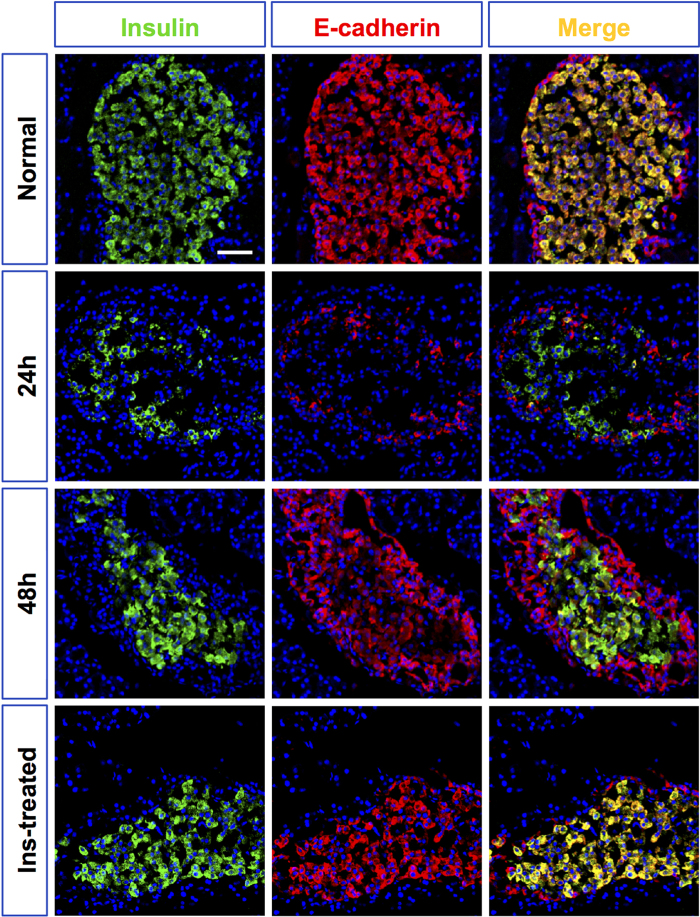
Temporal changes of E-cadherin expression in insulin+ cells following STZ treatment.The photomicrographs in the left column showed representative islets stained with anti-insulin (green), and the middle column with anti-E-cadherin (red) antibodies from normal control SD rats (Nor), STZ-treated rats at different time points (24 h, 48 h), and insulin-treated rats by day 7 (insulin-treated). The right column showed the merged images of the left and middle column. Nuclei were labeled with DAPI. Scale bars, 50 μm.